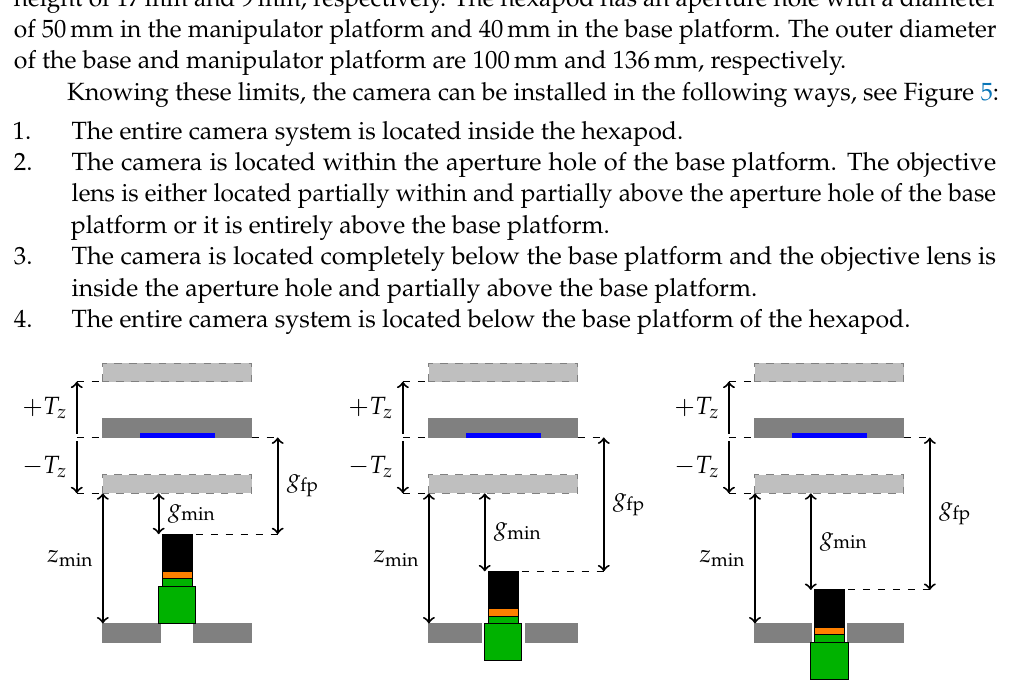
Figure 5. Possible integrations of the camera system in the